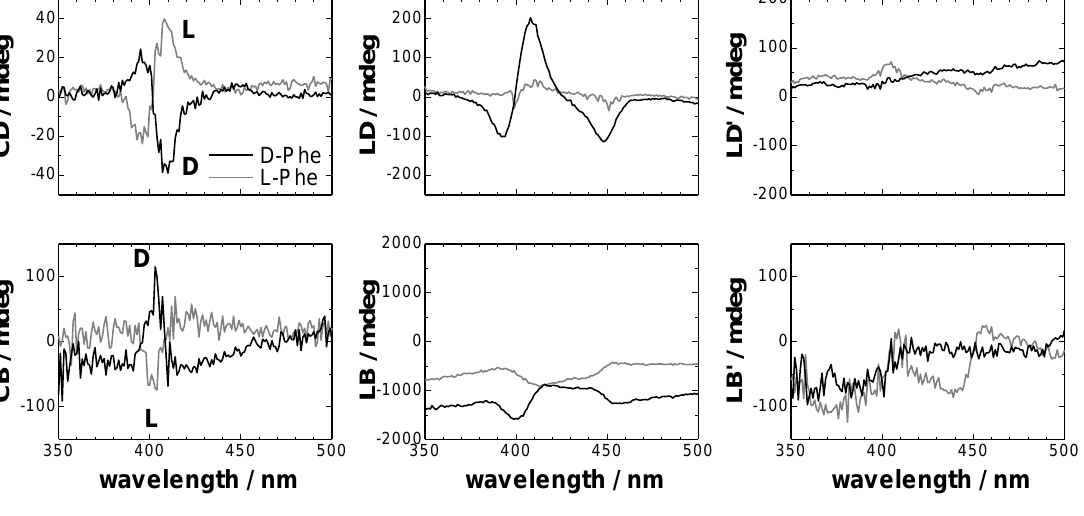
= 1.6 × 10 −4 M, [Phe] aq